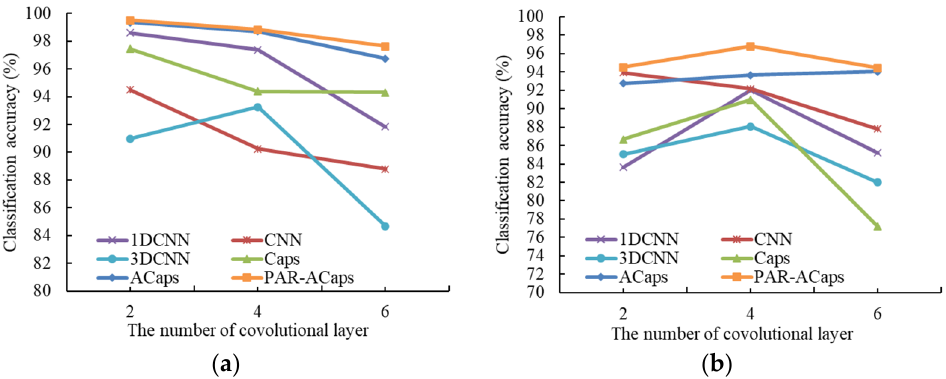
Figure 10. The changes of the classification accuracies of the 1DCNN, CNN, 3DCNN, Caps, ACaps, and PAR-ACaps for PU and SA datasets. ( a ) Classification accuracies derived from PU dataset. ( b ) Classification accuracies derived from SA dataset.